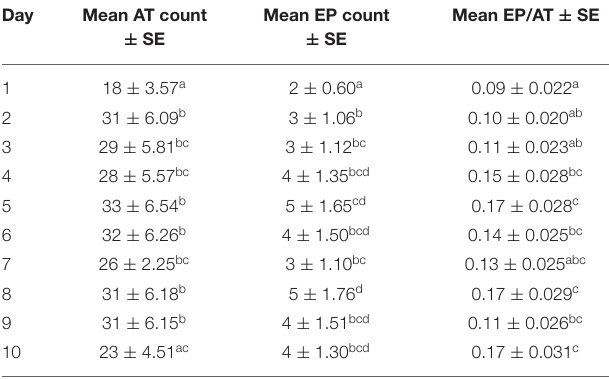
TABLE 1 | Model-based mean number of audio tone (AT), mean number electrical pulse (EP), and model-based probability of that an AT resulted in an EP (EP/AT) ± standard error of the mean (SE) of all cows across days